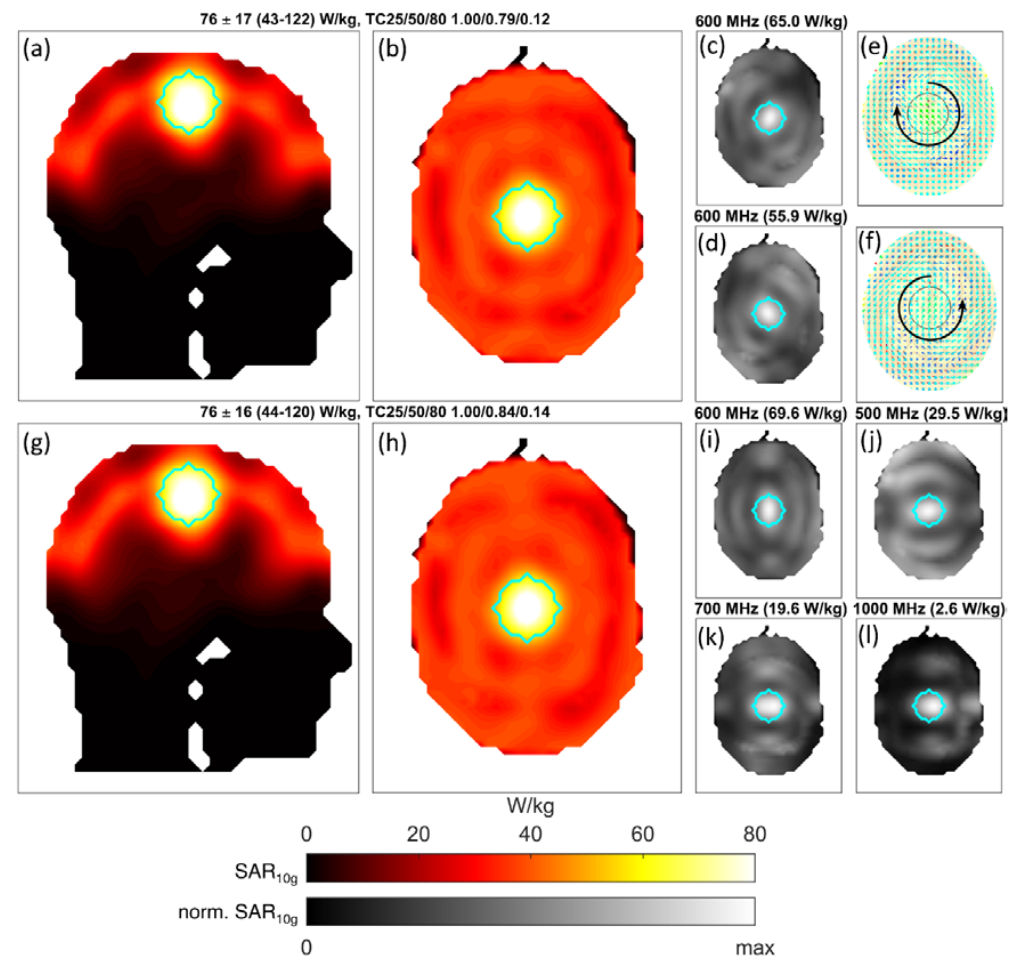
Figure 6. Results of the 3D heating example using the human head model. The target is again outlined in cyan and target SAR was set to 150 W/kg, minimizing the 2-norm of the deviation from this value. Measures of SAR within the target region are detailed in the header (Mean ± SD (Min–Max)), along with TC25, TC50, and TC80 values for the tumor. Images ( a ) and ( g ) show sagittal slices through the tumor center, whereas the other SAR plots represent axial maximum intensity projections over the whole volume. Images ( a ) and ( b ) show the achieved power deposition pattern when using only 600 MHz fields. This pattern is achieved by two time-multiplexed modes, whose patterns are shown scaled to their individual maximum in ( c ) and ( d ) analogous to the previous figures. These two modes correspond to two counterrotating circularly polarized electric fields inside the tumor. E-field vector snapshots and the rotation direction are shown in ( e ) and ( f ). This example demonstrates that the algorithm can arbitrarily mix polarizations within a single excitation (a circular polarization being comprised of two linear components) as well as yield di ff erently polarized time-multiplexed complementary solutions. The second row of results in ( g – l ) shows the optimum result when allowing the use of all frequencies between 100 and 1000 MHz. From a target coverage standpoint, this solution performed only slightly better, with an identical mean but modestly lowered maximum, elevated minimum, and lower standard